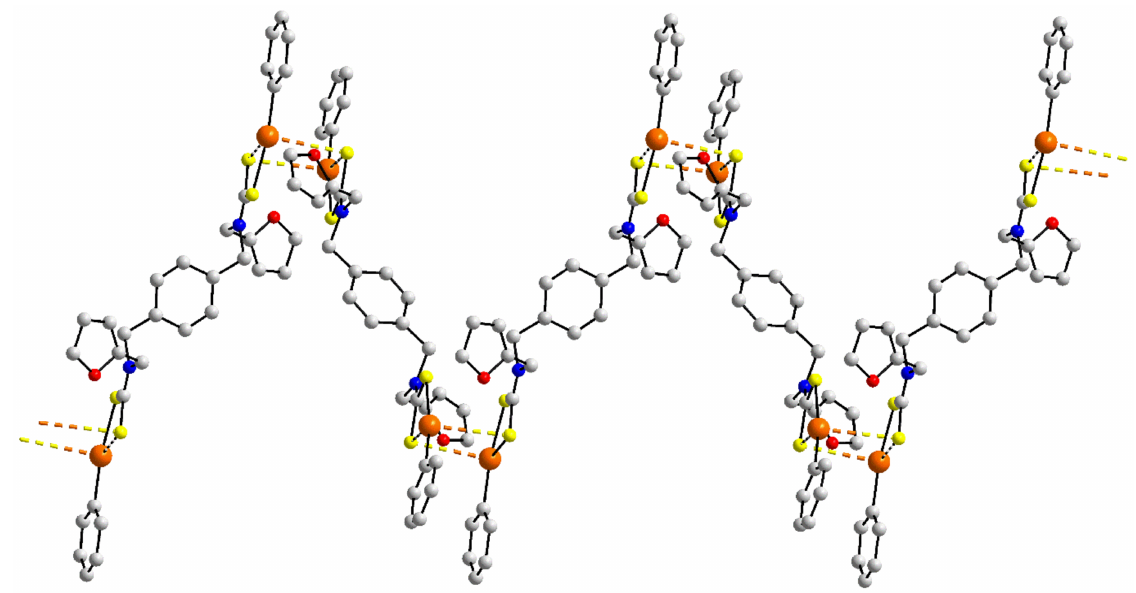
Figure 17. Supramolecular association in a zigzag chain in di-nuclear 47 .